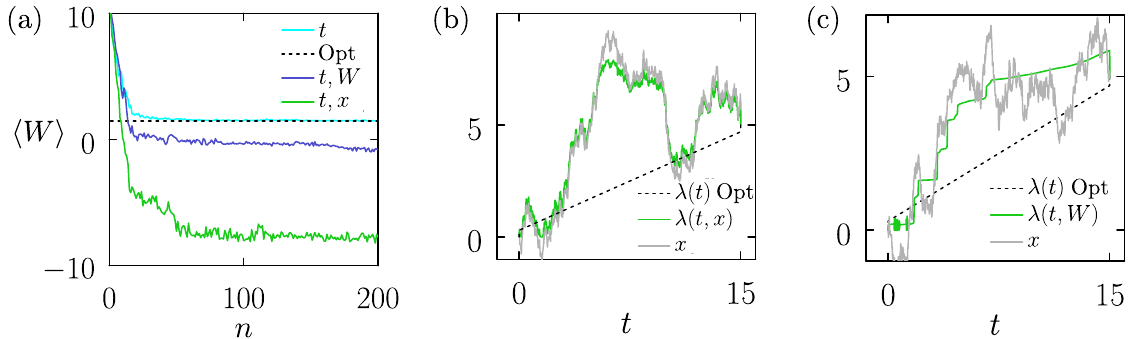
FIG. 5. Supplement to Fig. 2. (a) Similar to Fig. 2(e) but including the outcome of training when the demon inputs are time t and time- integrated work W (blue). Some work can be extracted in this case, but less than with time and bead position as input (green). Panels (b) and (c) are similar to Fig. 2(g). Panel (b) shows that, knowing the bead position, the demon can move the trap so as to extract large amounts of work from position fluctuations. (c) Time-integrated work, which contains less information about position fluctuations. This becomes increasingly true as time elapses. The demon can use this information to extract work but less efficiently than if presented with the instantaneous